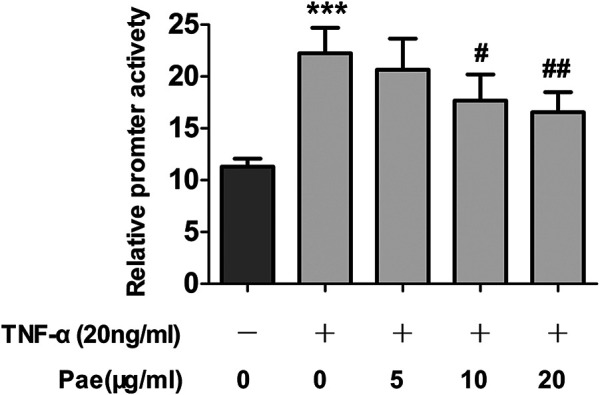
Paeonol inhibits TNF‐α‐induced transcriptional activity of NF‐κB in A549 cells stimulated with TNF‐α. A549 cells were treated with paeonol at indicated concentrations and/or TNF‐α (20 ng/ml) for 24 h. Dual‐luciferase assays were used to determine the transcriptional activity of NF‐κB, n = 3 (independent experiments). ***p < 0.001 versus control, #p < 0.05 versus TNF‐α, ##p < 0.01 versus TNF‐α.